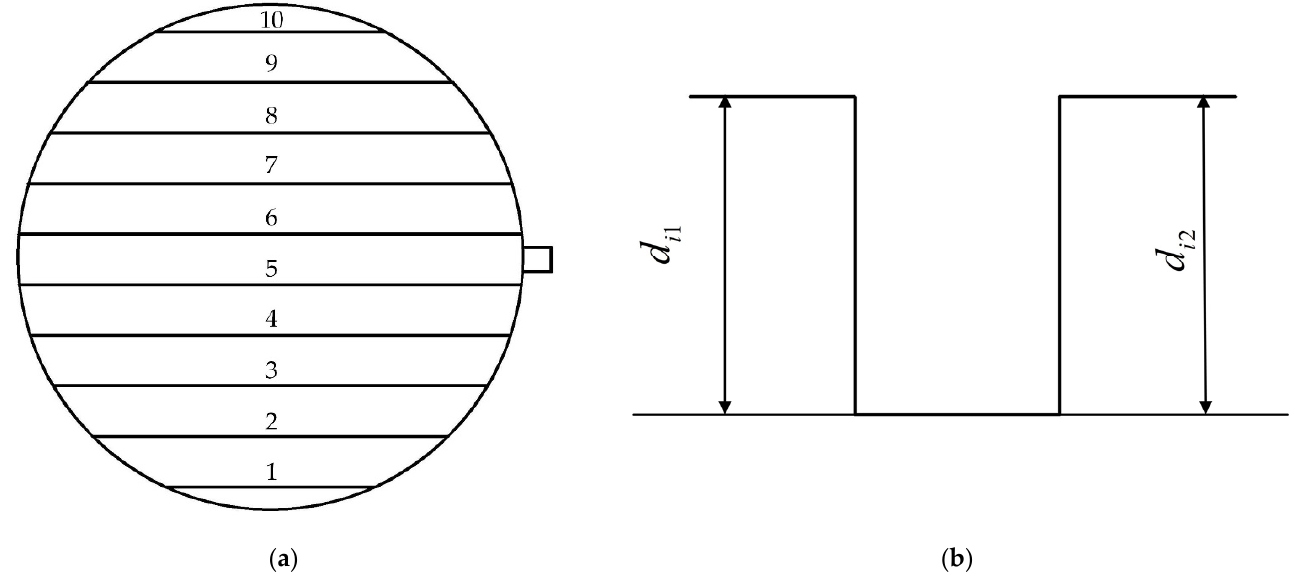
Figure 3. Schematic diagram of microstructure measurement: ( a ) microstructure measurement position; ( b ) methods for measuring microstructures.